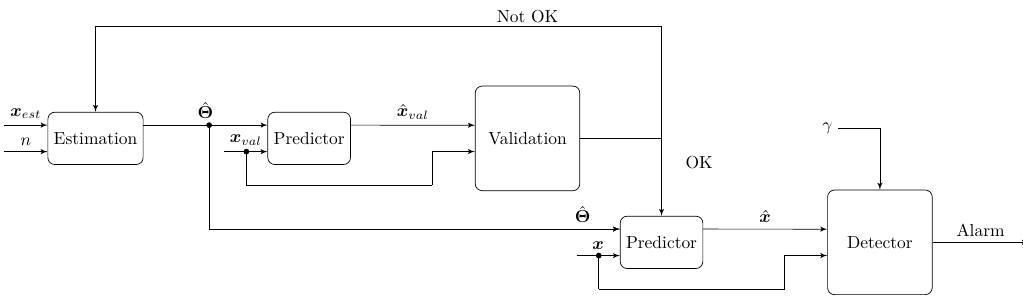
Figure 3. Diagram of the modeling and detection